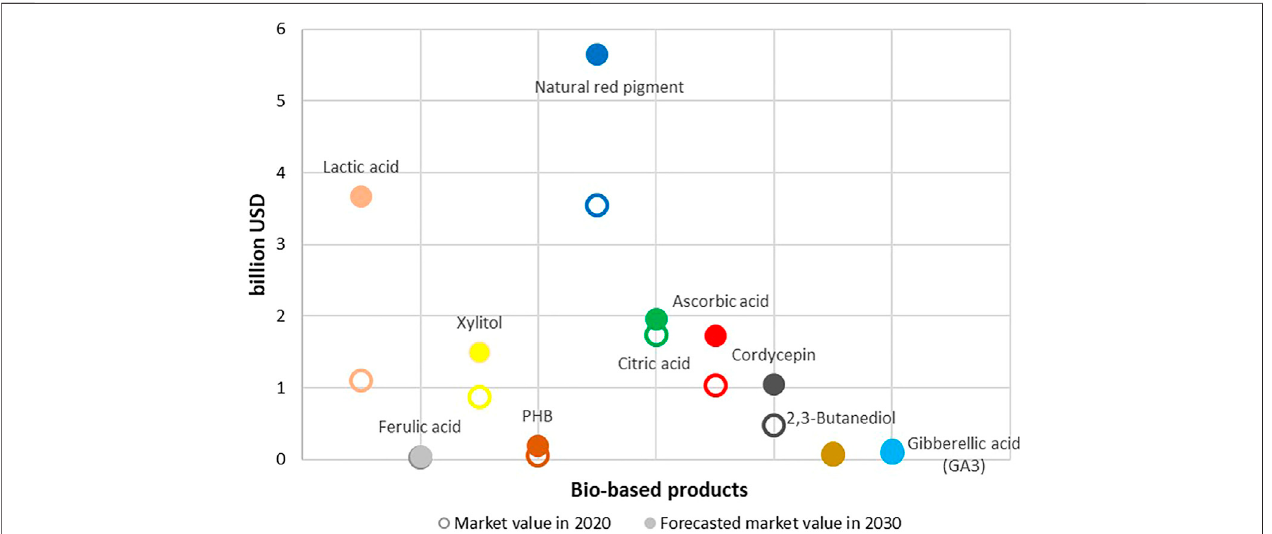
FIGURE2| Marketsharesofhigh-valueBSG-basedproducts(PHBasapartofthePHAgroup;Naturalredpigmentasapartofnaturalpigmentgroup)in2020and estimation for 2030.